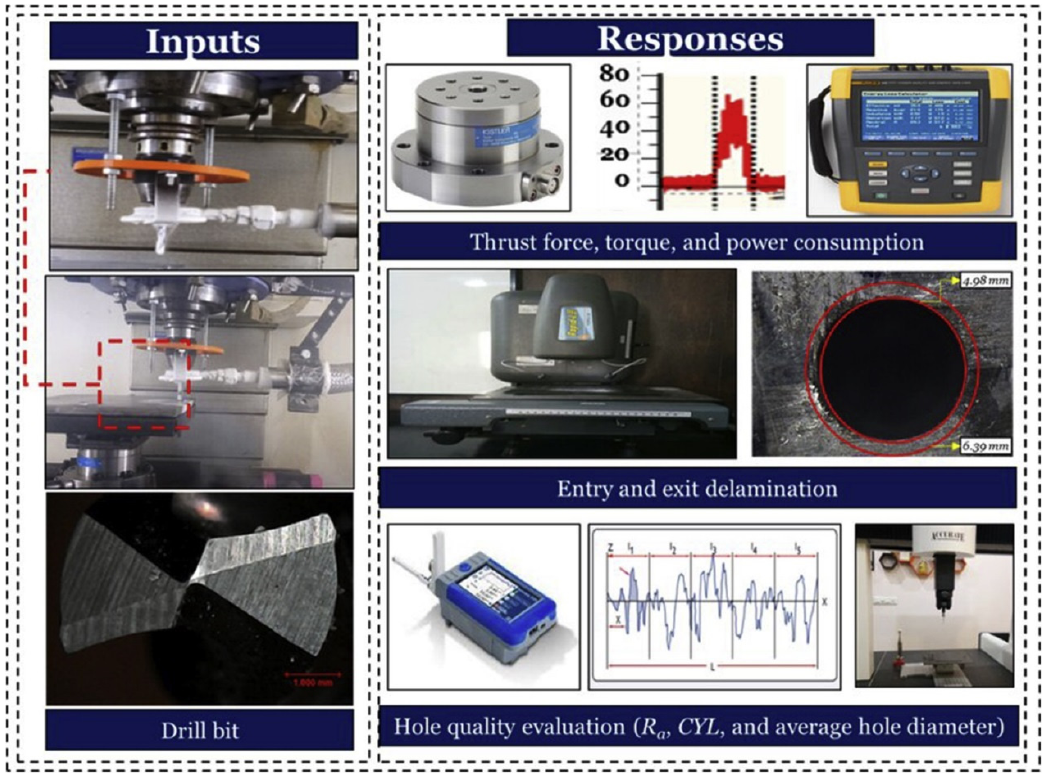
Figure 10. Inputs, experimental setup and responses [134].